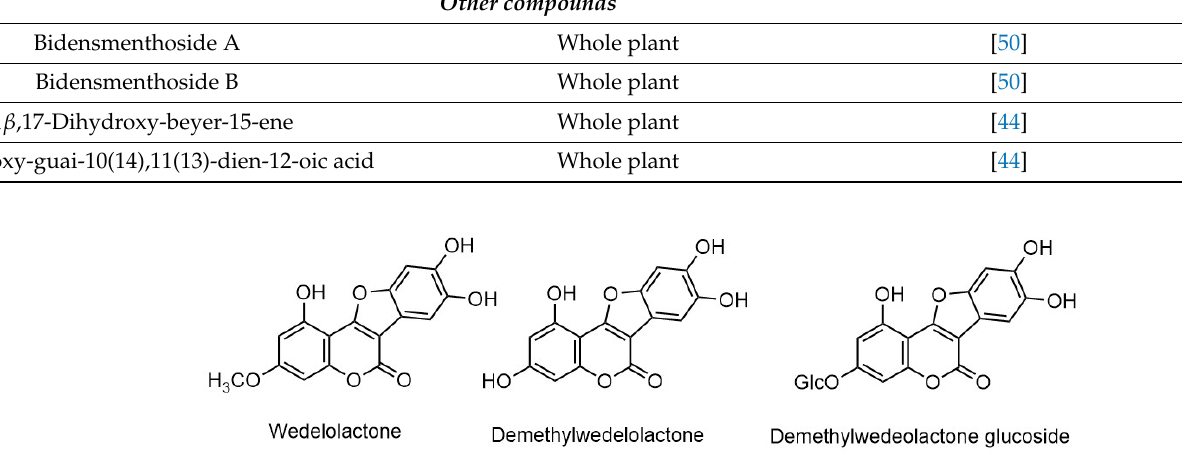
Figure 3. Structures of major coumestan derivatives.